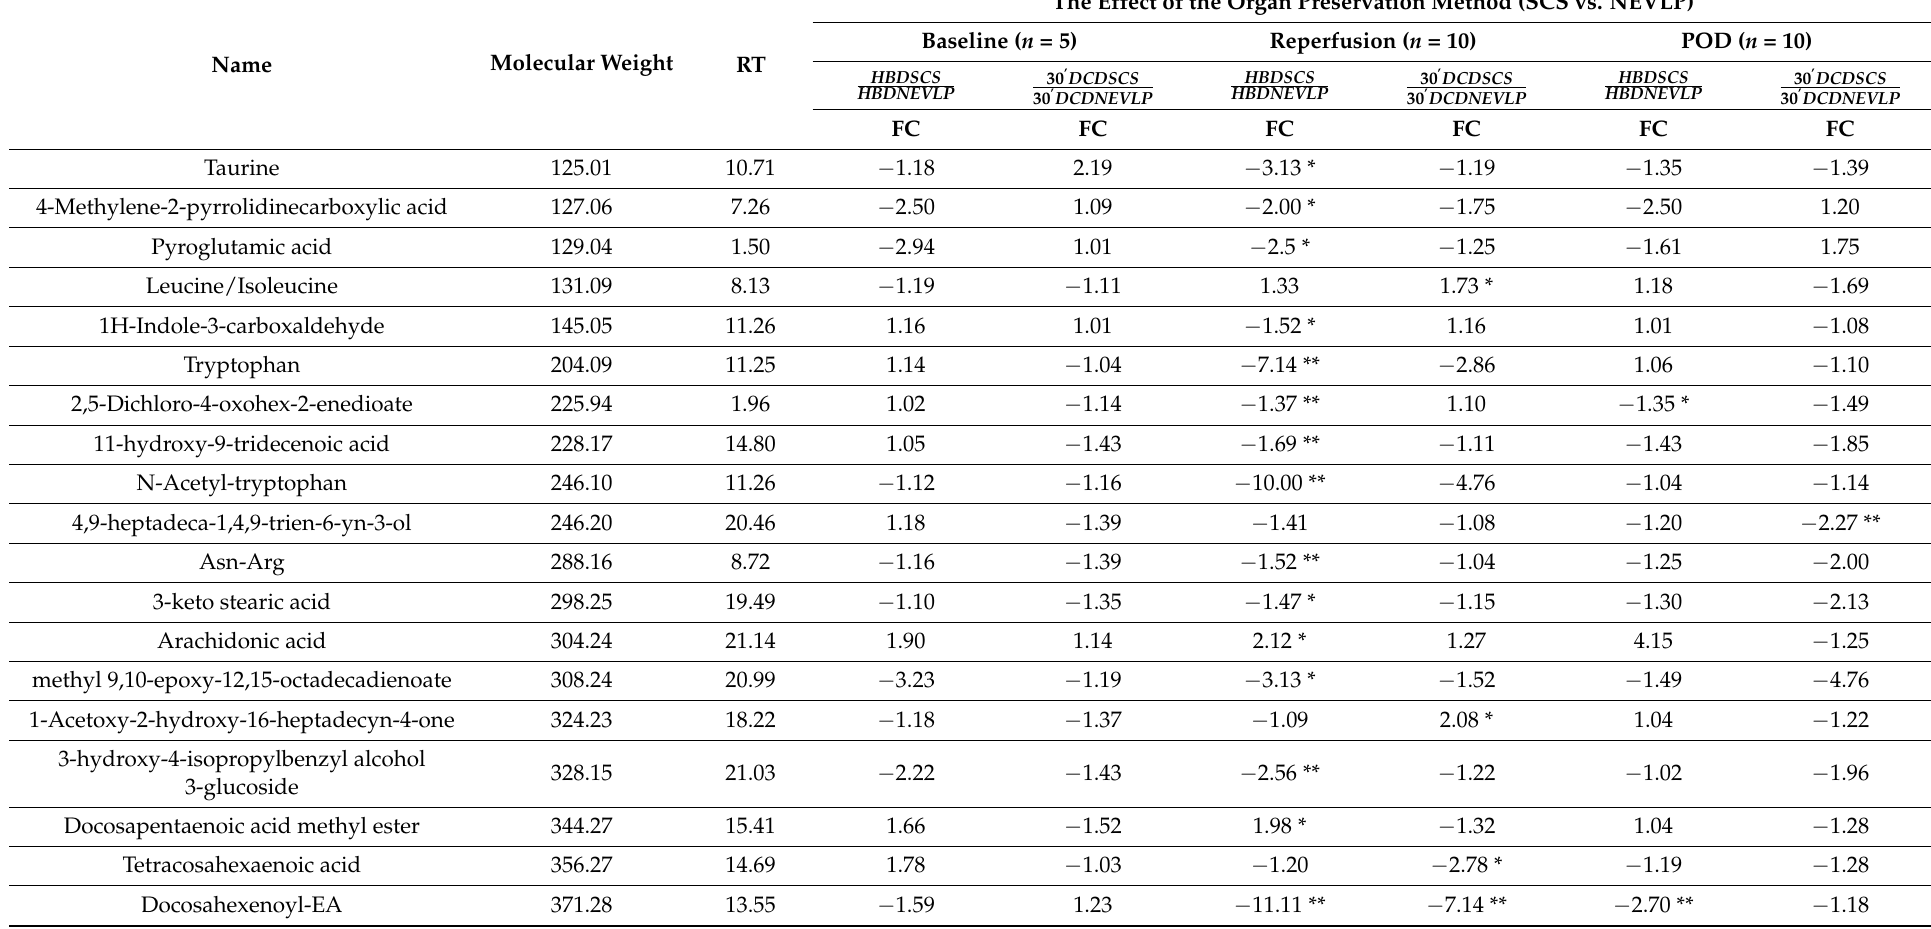
Table 1. Statistically significant compounds identified in SCS- and NEVLP-preserved organs from HBD and 30 (cid:48) DCD donors at particular time points. Data were acquired in positive ionization mode. The Kruskal—Wallis test and multiple (post-hoc) mean-rank comparisons were used to select the metabolites statistically significantly different from the SCS and NEVLP methods. Results are presented as fold